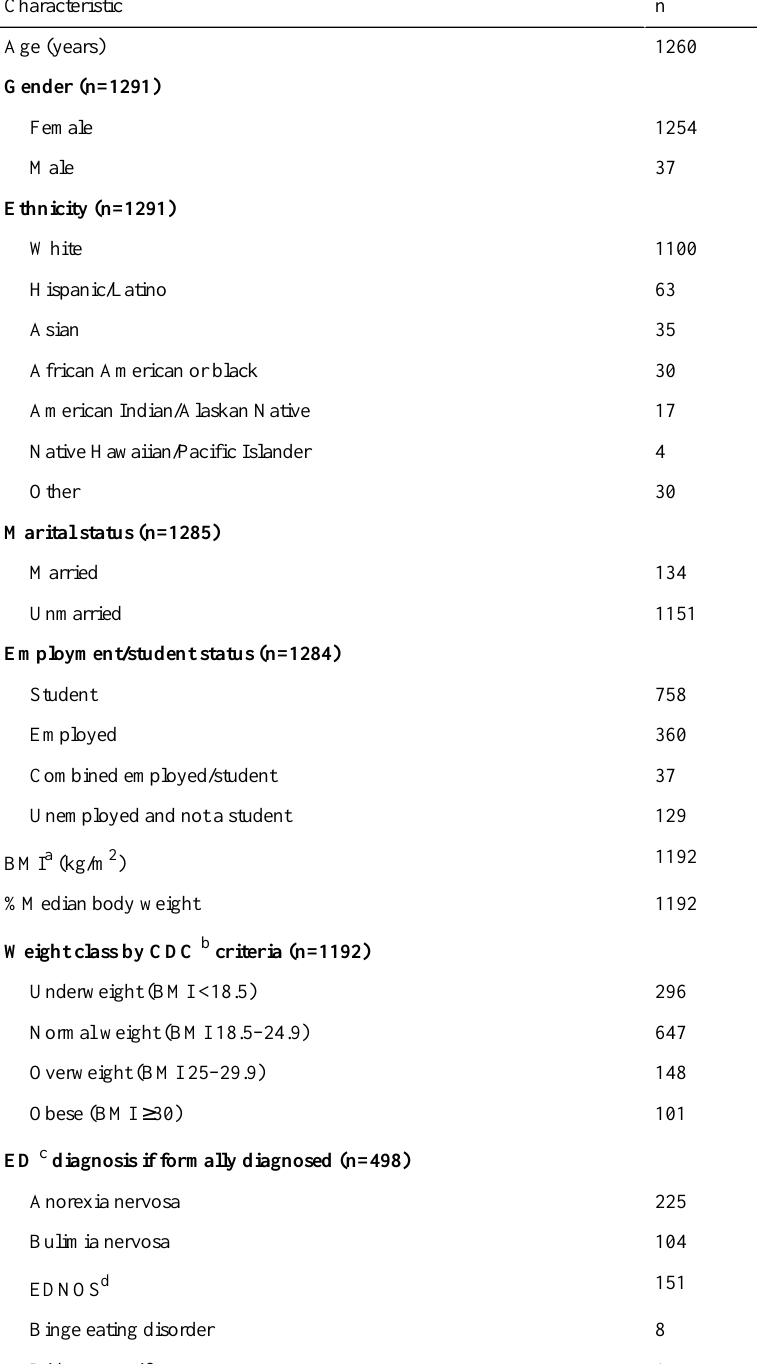
Table 1. Clinical and demographic characteristics of study participants (N =